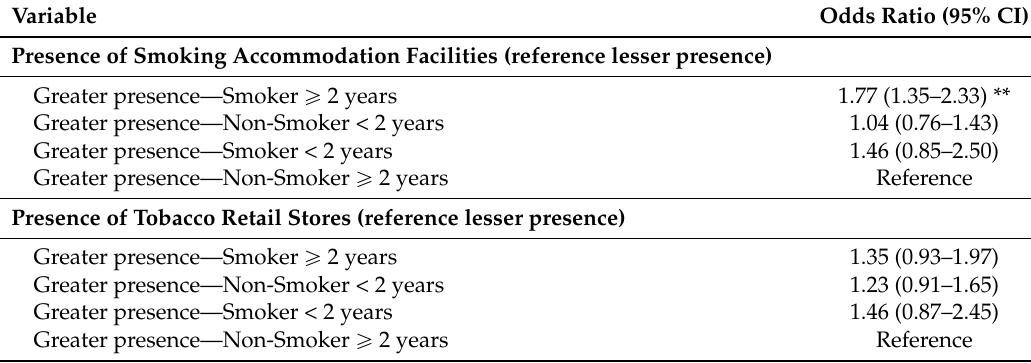
Table 4. Results of multinomial multilevel regression models predicting smoking trajectory over 2 years from CSSS-level exposures among 2070 adults living in Montreal, Canada in